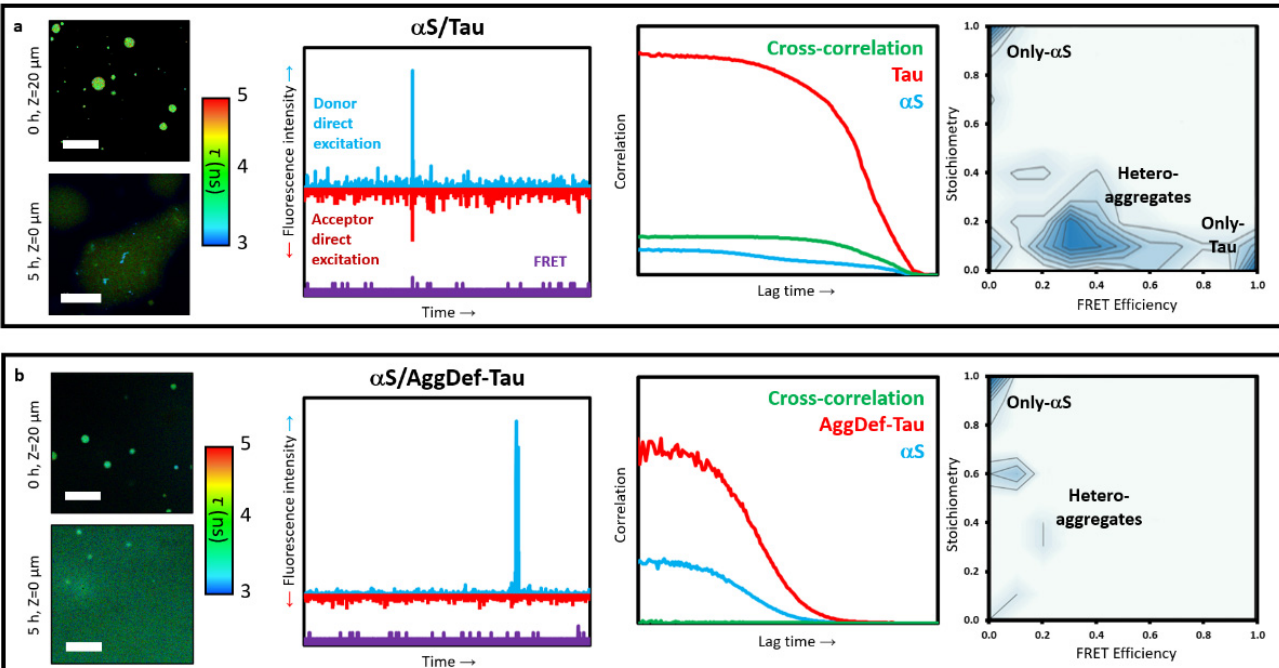
Figure 5. Analysis of the LLPS-derived hetero-aggregates composed of α S and Tau by diffusion-based single-particle fluorescence analysis. Analysis of the aggregates generated inside the α S/Tau liquid coacervates in the presence of the wild-type ( a ) or an aggregation deficient ( b ) Tau variant. Identical analyses were performed for the two systems. At the left panels, representative fluorescence lifetime imaging microscopy (FLIM) images of the liquid protein coacervates immediately formed inside the solution (upper panels) and after 5 h incubation at the bottom of the slide (lower panels). Scale bars represent 20 μ m in all images. Aggregates in the interior of the coacervates are readily detected by a significant reduction in fluorophore lifetimes (blue puncta). At the centre-left panels, typical TCCD/smFRET time traces for each system are represented: in blue, the donor emission upon direct excitation, in red the acceptor emission after direct excitation, and in purple the acceptor emission after indirect FRET excitation. At the centre-right panels, representative auto- and cross-correlation curves of the dispersed aggregate solutions obtained upon identical sample treatments. At the right panels, the stoichiometry ( S ) vs. E FRET analysis for the dispersed aggregate solutions are shown. Adapted from Gracia, P.; et al. Molecular Mechanism for the Synchronized Electrostatic Coacervation and Co-Aggregation of Alpha-Synuclein and Tau. Nat Commun 2022, 13 , 1–16,